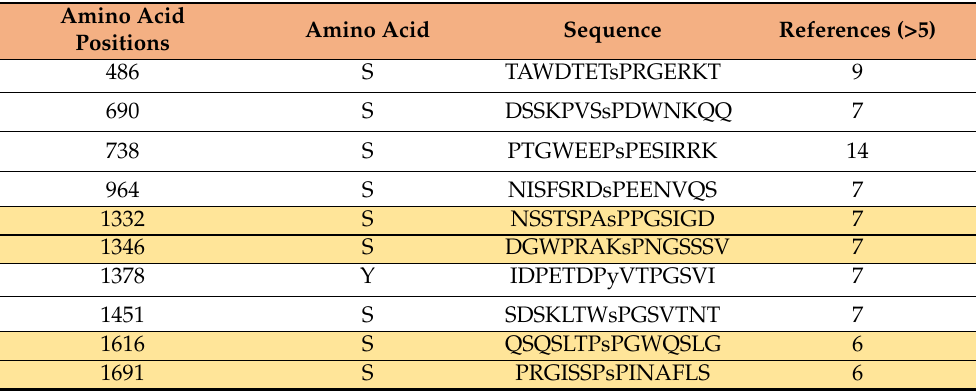
Table 1. Phosphorylation sites of TNRC6A registered in PhosphoSitePlus.